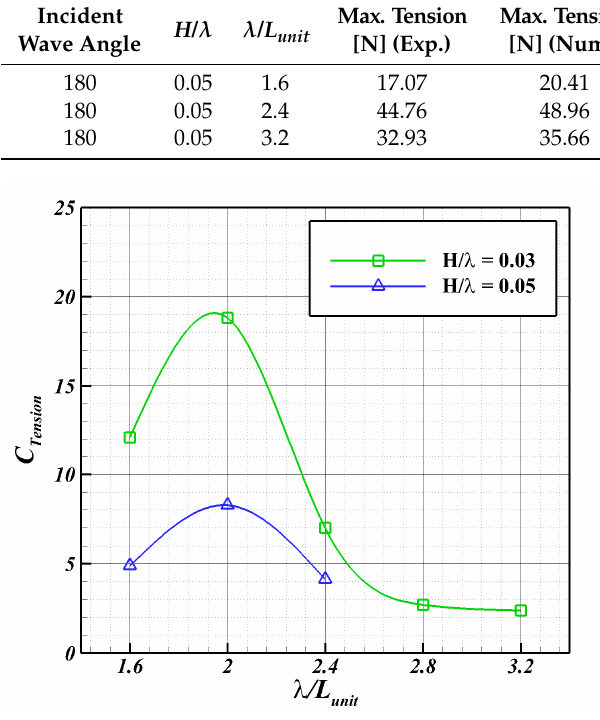
Figure 24. Comparison of tension coefficient according to wave steepness.